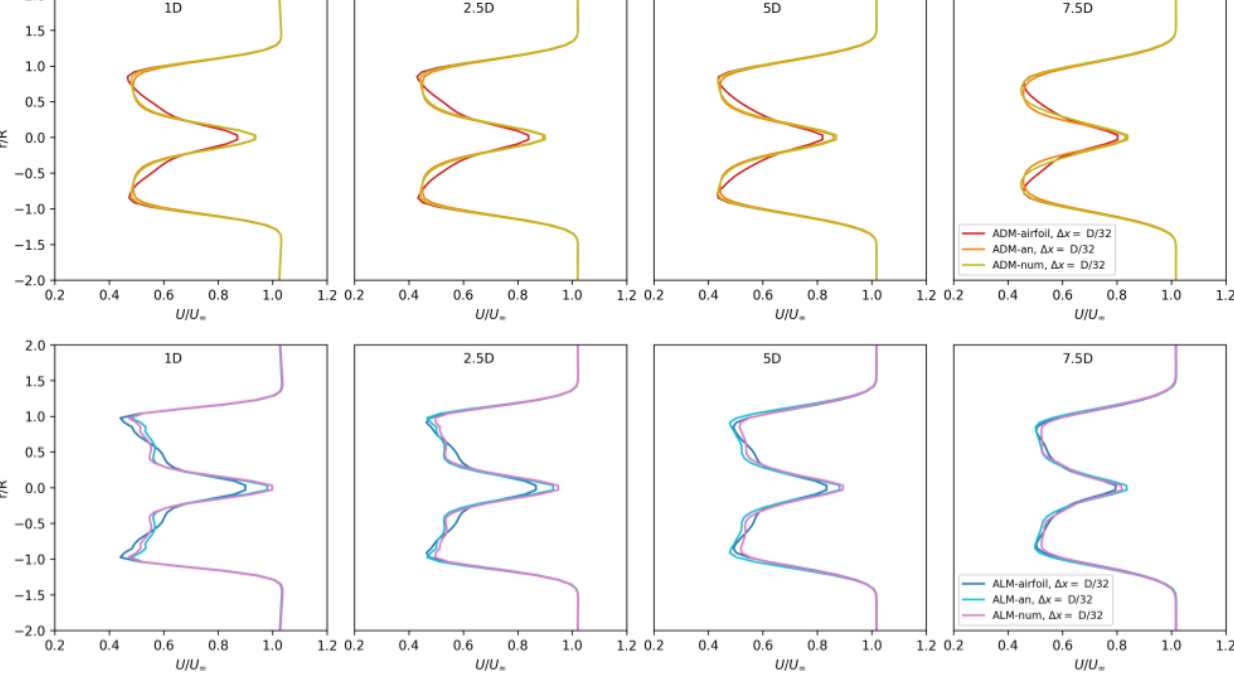
Figure 5. Velocity magnitude comparison of the wake using different models for the single-turbine case under uniform velocity inflow conditions of U ∞ = 8ms − 1 : ADM (top panels) and ALM (bottom panels).